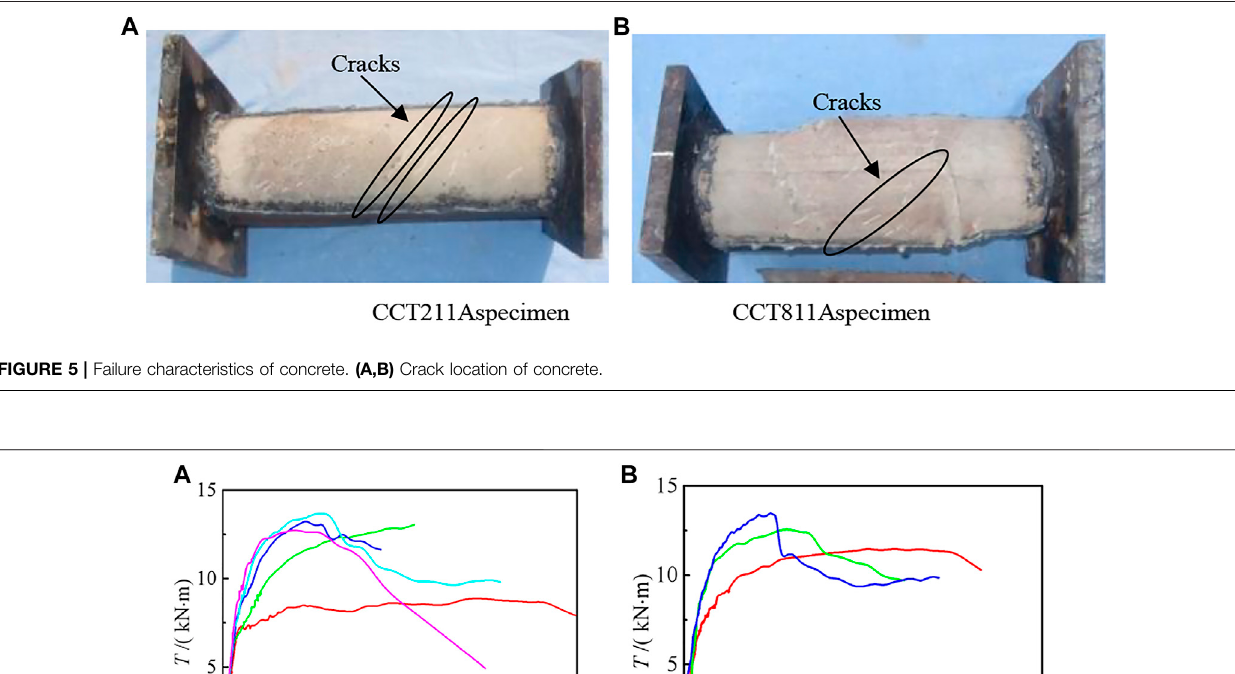
Carbon fi ber fabric is a unidirectional fabric woven by Toray T700 12 K carbon fi ber in Japan. The thickness of the single layer